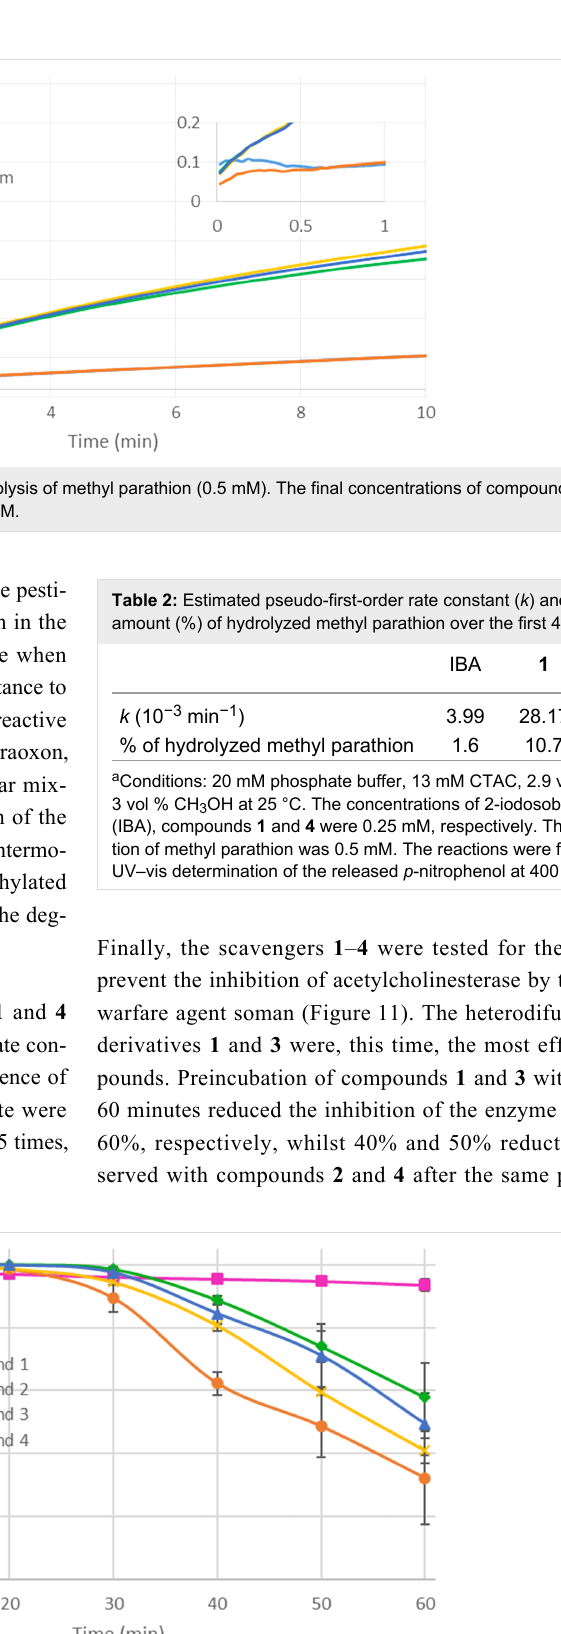
Figure 11: Ability of compounds 1 – 4 in preventing the inhibition of acetylcholinesterase by soman (GD).